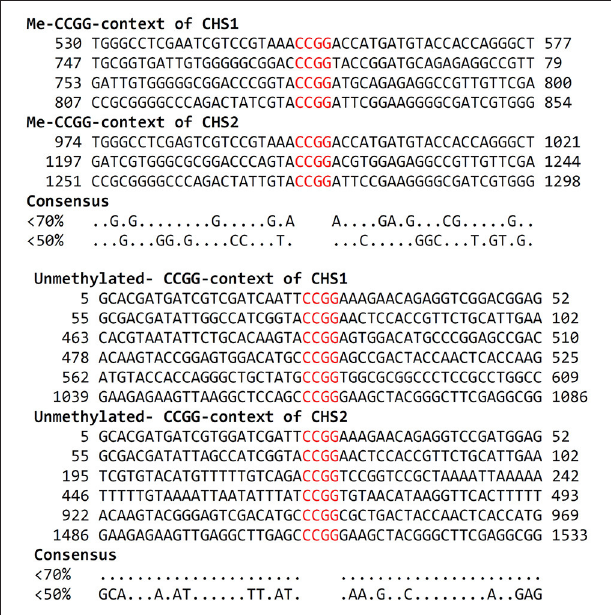
FIGURE 10 | Alignment of -CCGG- motifs context of CHS gene. The nearest vicinity of methylated and unmethylated -CCGG- motifs in CHS1 and CHS2 isoforms in the flax genome was compared. According to each motif, 22 nucleotides upstream and downstream of the -CCGG- motifs were analyzed. For each -CCGG- motif, GC content (%) was calculated (presented on the left).